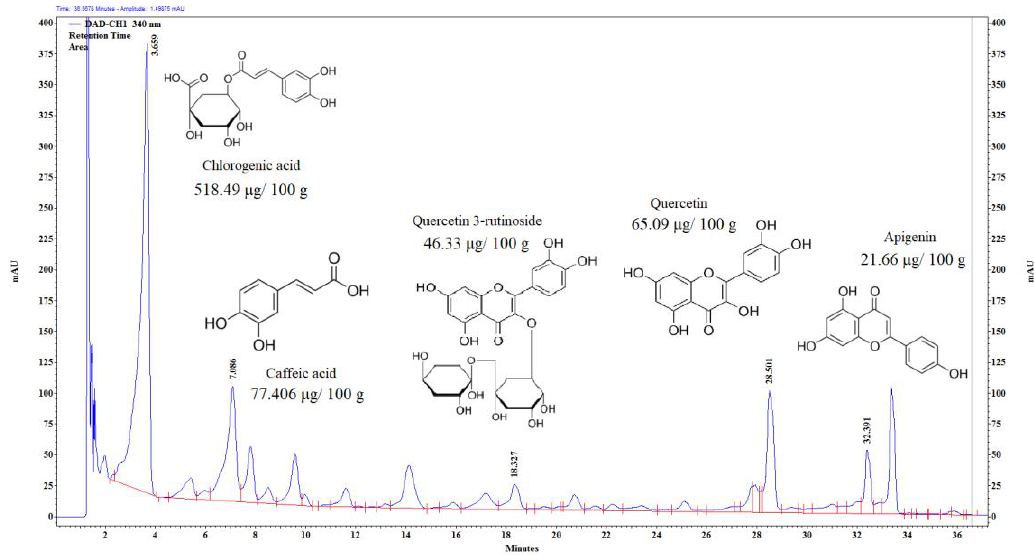
Figure 2. UHPLC chromatogram of sour cherry at 340 nm. Confirmed by standard.